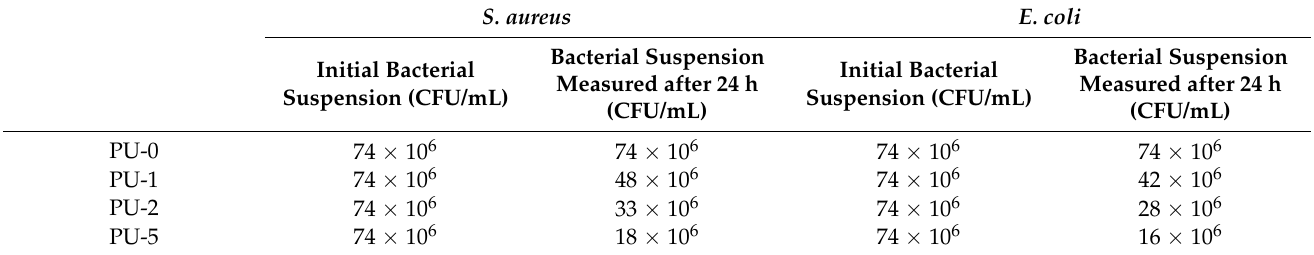
Table 8. Microbial properties of PUR composite foams against Staphylococcus aureus and Escherichia coli. [9].